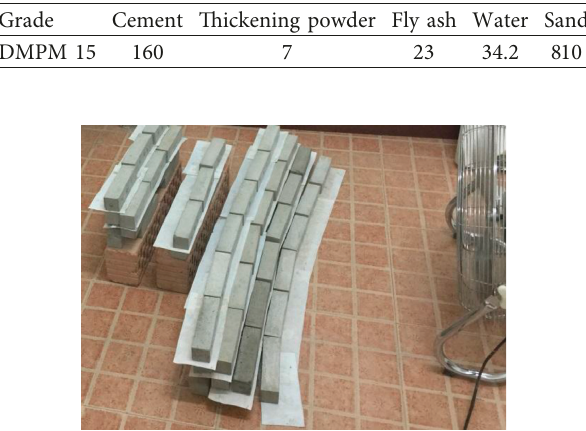
Table 1: Mix proportions of dry-mix plaster mortar (g).